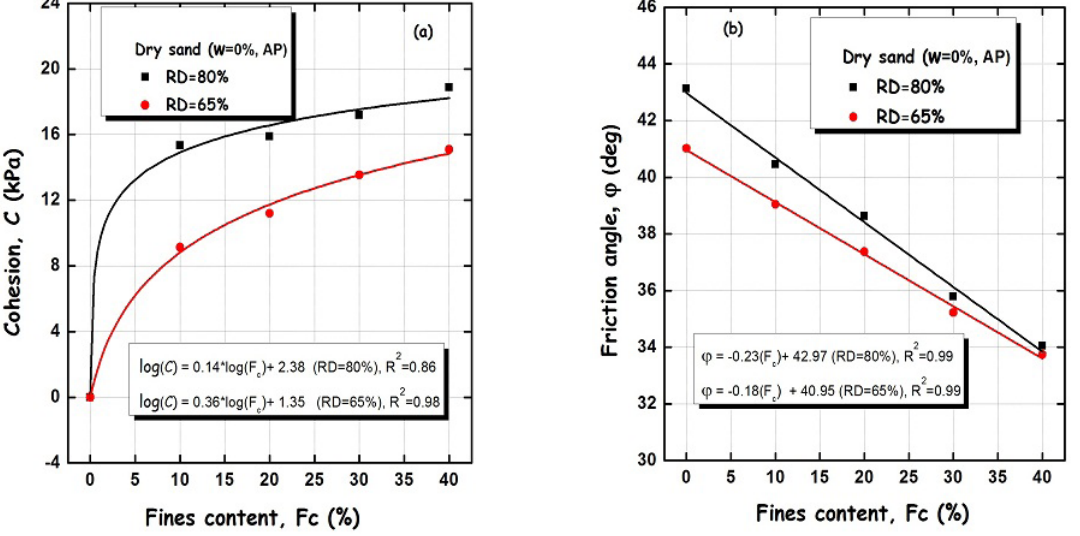
Figure 11 : Effect the fines content on the mechanical characteristics of (clean) sand, (a) cohesion versus fines content, (b) friction angle versus fines